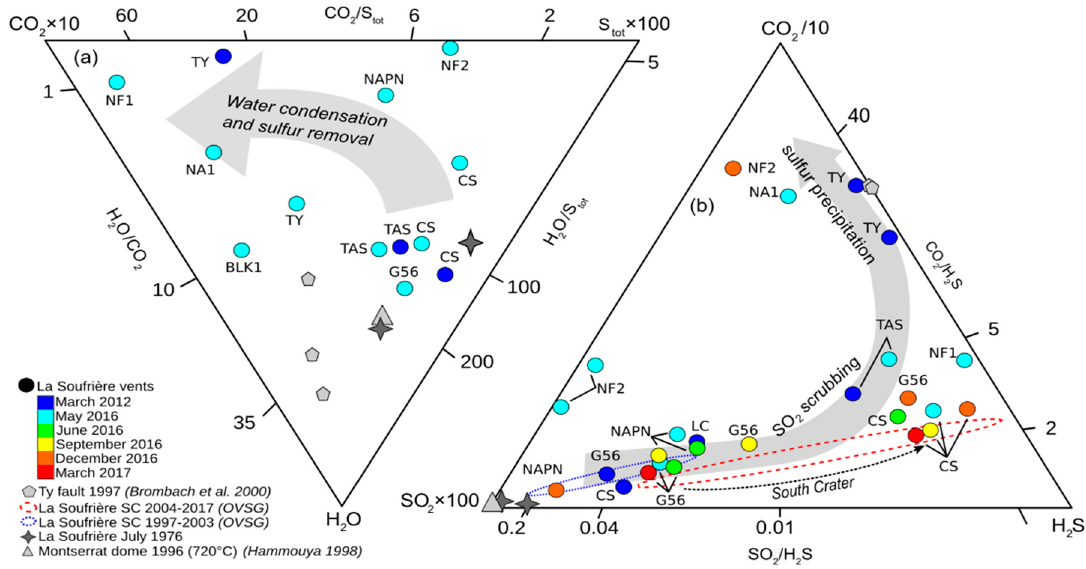
Figure 5. Gas compositions and trends in ternary diagrams ( a ) H 2 O-CO 2 -S tot and ( b ) CO 2 -SO 2 -H 2 S. Coloured circles represent MultiGAS-derived molar ratios of La Soufrière fumaroles in the period 2012–2017. Grey triangle: Montserrat-type magmatic end-member. Grey crosses: La Soufrère fumarolic gases during the 1976 eruptive crisis (see text). Dashed blue and red lines delineate the compositional ranges of CS fumarole obtained from direct sampling during the period 1997–2003 and 2004–2017, respectively.